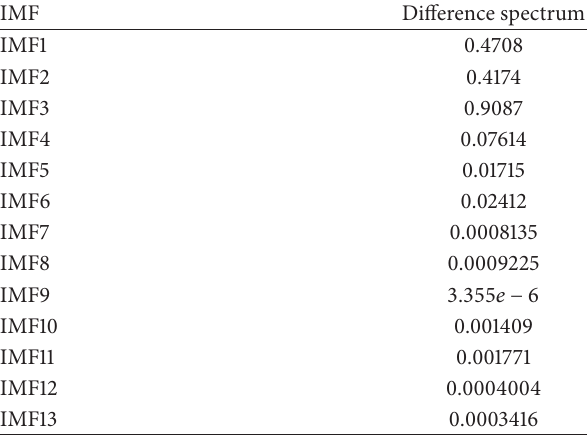
Figure 13: The fault signal of bearing inner race: (a) time-domain waveform; (b) frequency spectrum; (c) envelope spectrum. Table 3: Difference spectrum of the bearing inner race correspond- ing to IMFs.